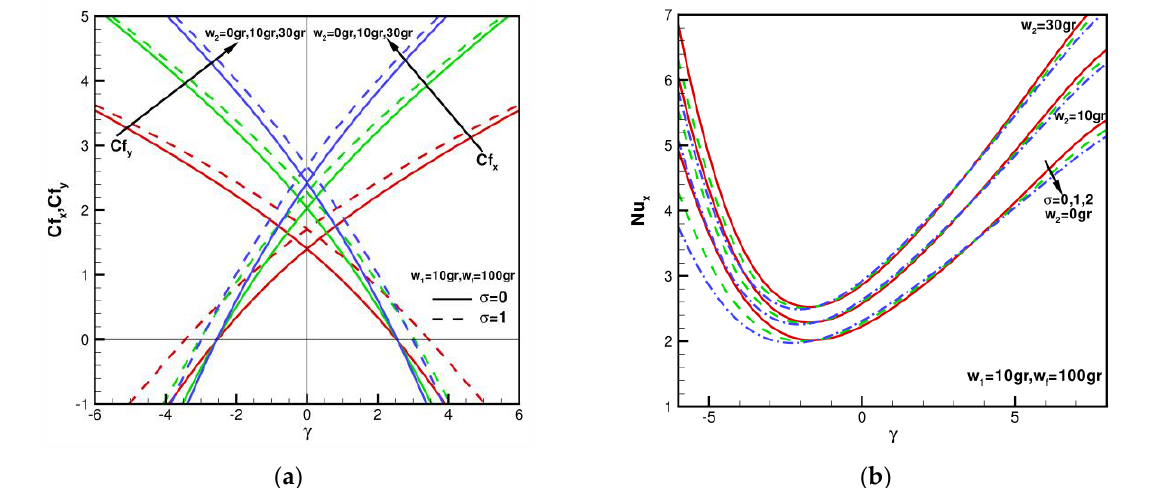
Figure 9. Skin friction coefficients Cf x , Cf y and local Nusselt number Nu x against γ when w 1 = 10 gr, w f = 100 gr, w 2 = 0, 10 gr, 30 gr, σ = 0, 1, 2, 5, and Pr = 6.2: ( a ) the distribution of Cf x , Cf y with n 1 = n 2 = 3 (sphere); ( b ) the distribution of Nu x with n 1 = n 2 = 3 (sphere).